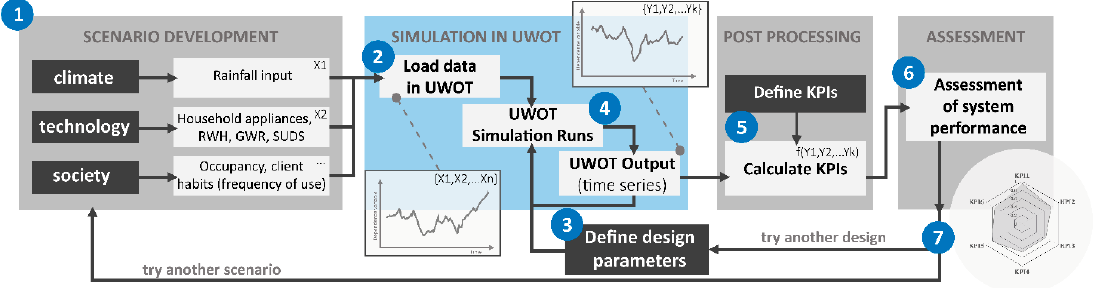
Figure 3. The developed simulation-based framework in the form of an assessment chain.